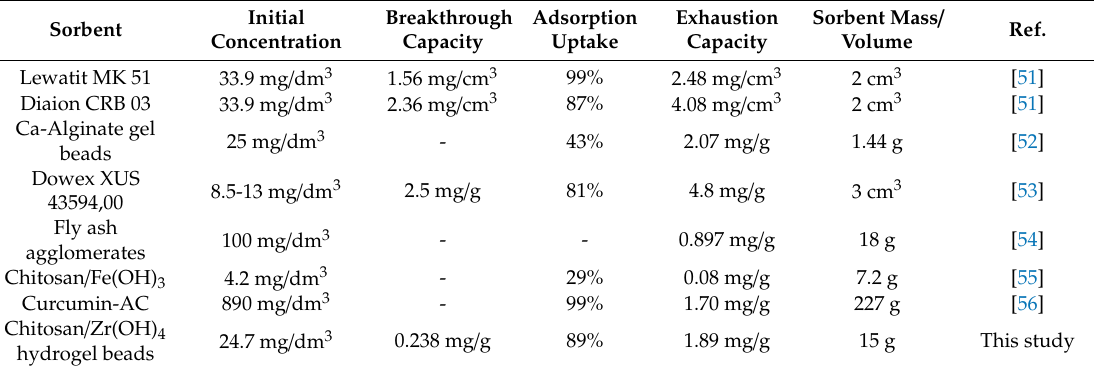
Table 4. Summary of selected column studies on boron removal conducted on commercial and new sorbents.